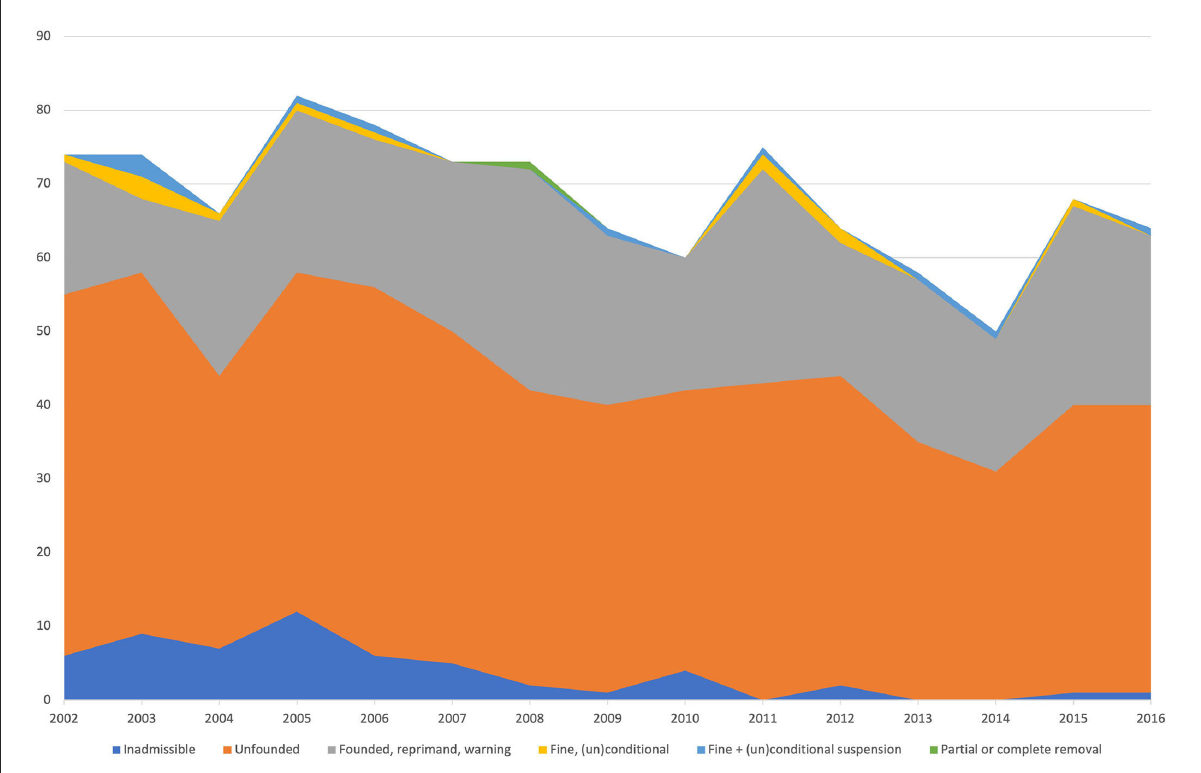
FIGURE3 Rulings of the VDC for only cases filed from 2002 to 2016. The color corresponds with the ruling of the VDC.